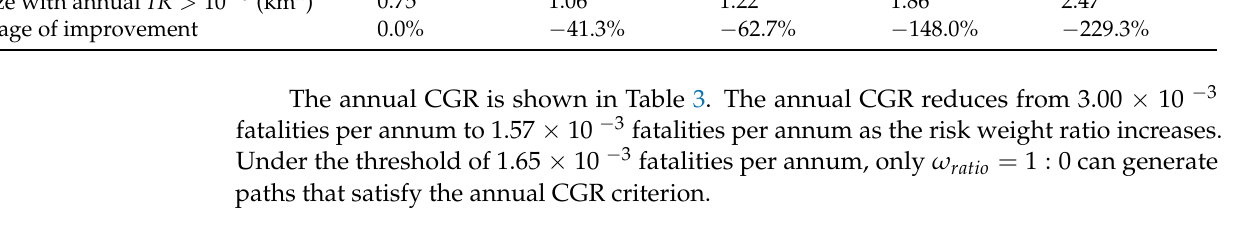
Table 3. Annual CGR with different risk weight ratios.